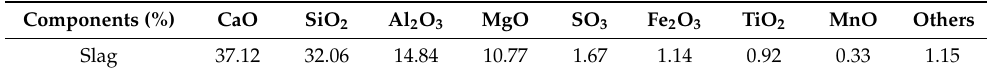
Table 1. The chemical composition of